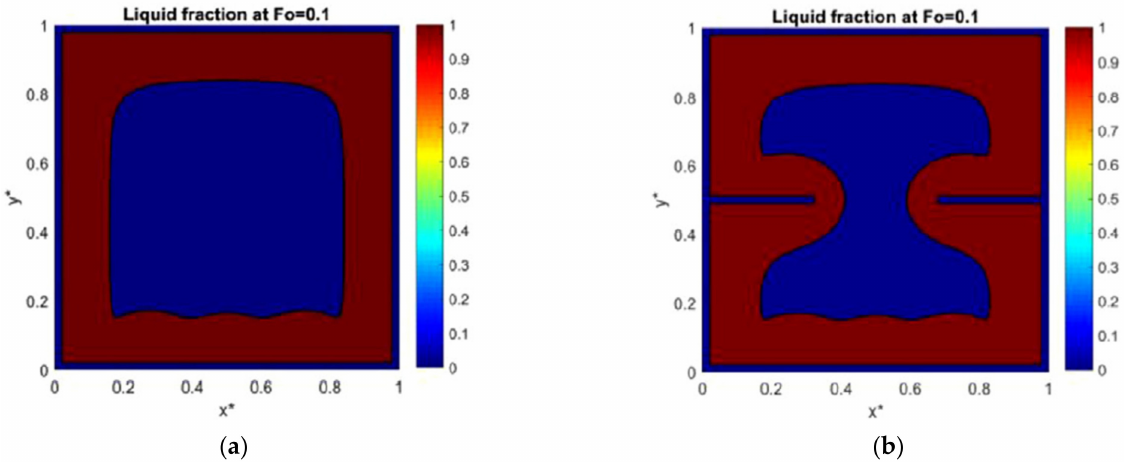
Figure 6. Comparison of melting fronts for a cavity ( a ) without fins and ( b ) with fins from the study published by Ren and Chan